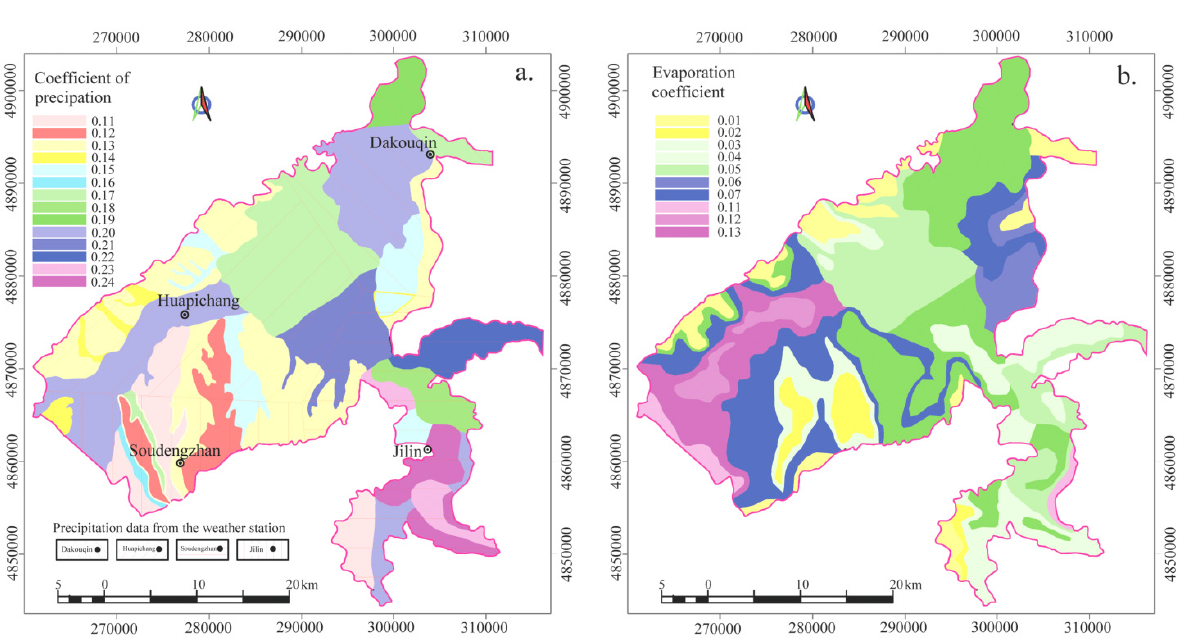
Figure 8. Zones for Recharge (RCH) and evapotranspiration (ET) packages, where different colors represent different zones. ( a ) Zones are superimposed by precipitation and irrigation for the RCH Package; ( b ) zones of evaporation for the ET